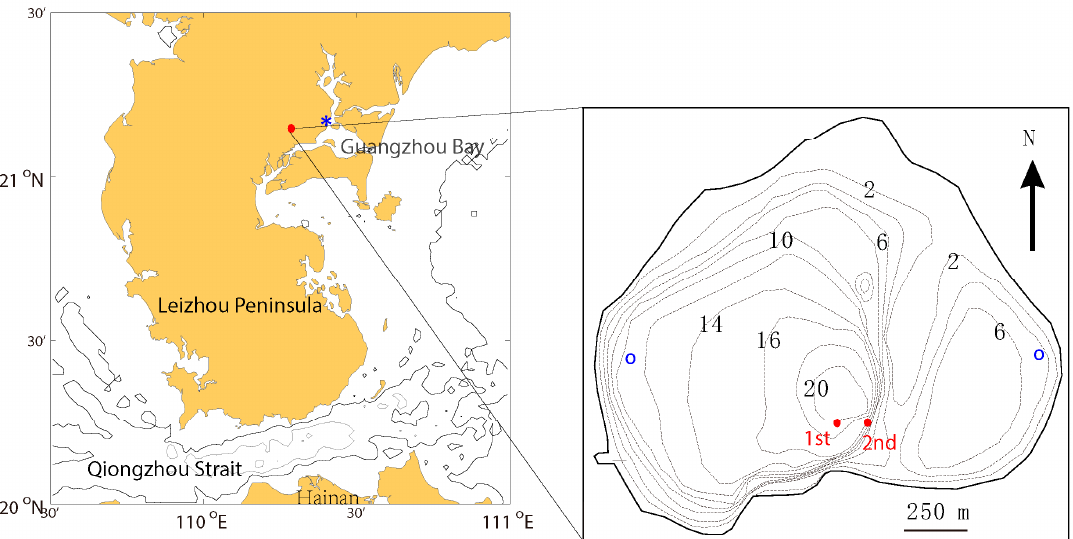
Figure 1. Location, map, and bathymetry contour of Huguangyan Maar Lake, China. The blue asterisk in the left panel shows the location of tidal gauge in the estuary. The contour lines in the right panel show the bathymetry of the lake in meter, and the two red dots indicate the observation points, while the two blue circles show the locations to calculate the intrinsic oscillations of the lake in Section 3.2.